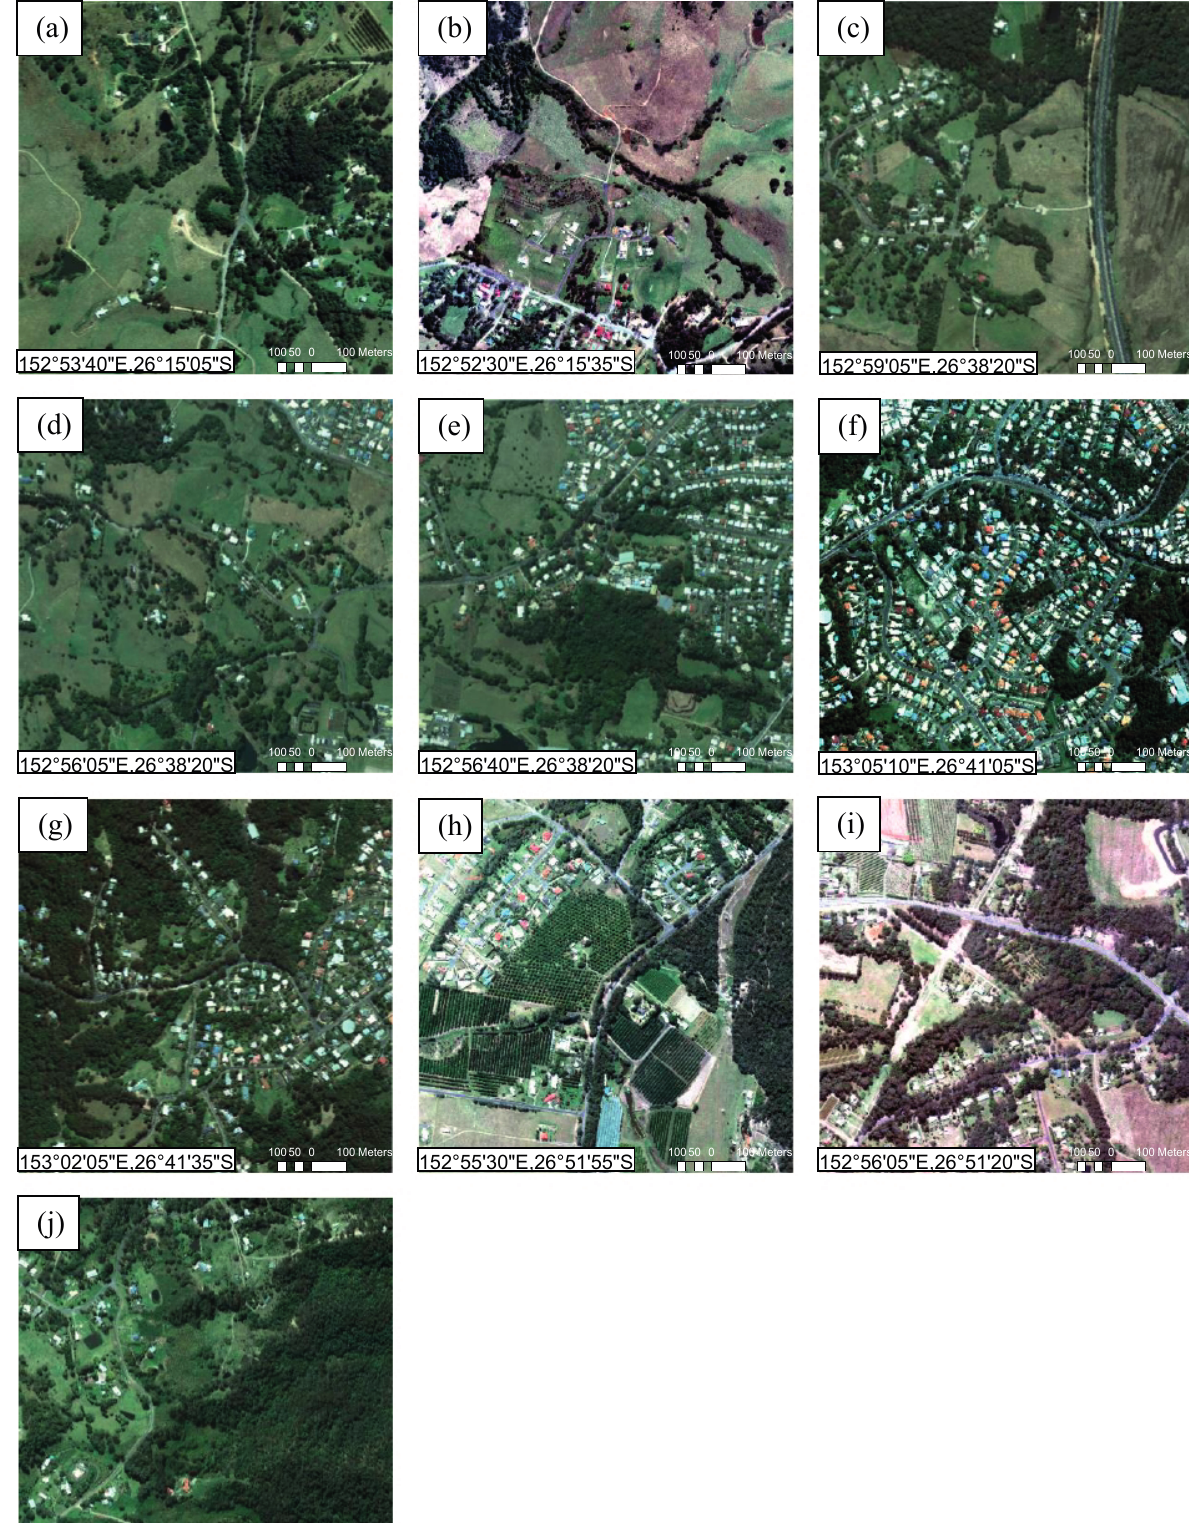
Figure 2. Ten selected orthophoto tiles in the Sunshine Coast Region represented as true colour composites each covering 1 km × 1 km. ( a , b ) area around Kin Kin; ( c – e ) area around Nambour; ( f , g ) area around Buderim; and ( h – j ) area around Beerwah. Coordinates represent the approximate centre of each image